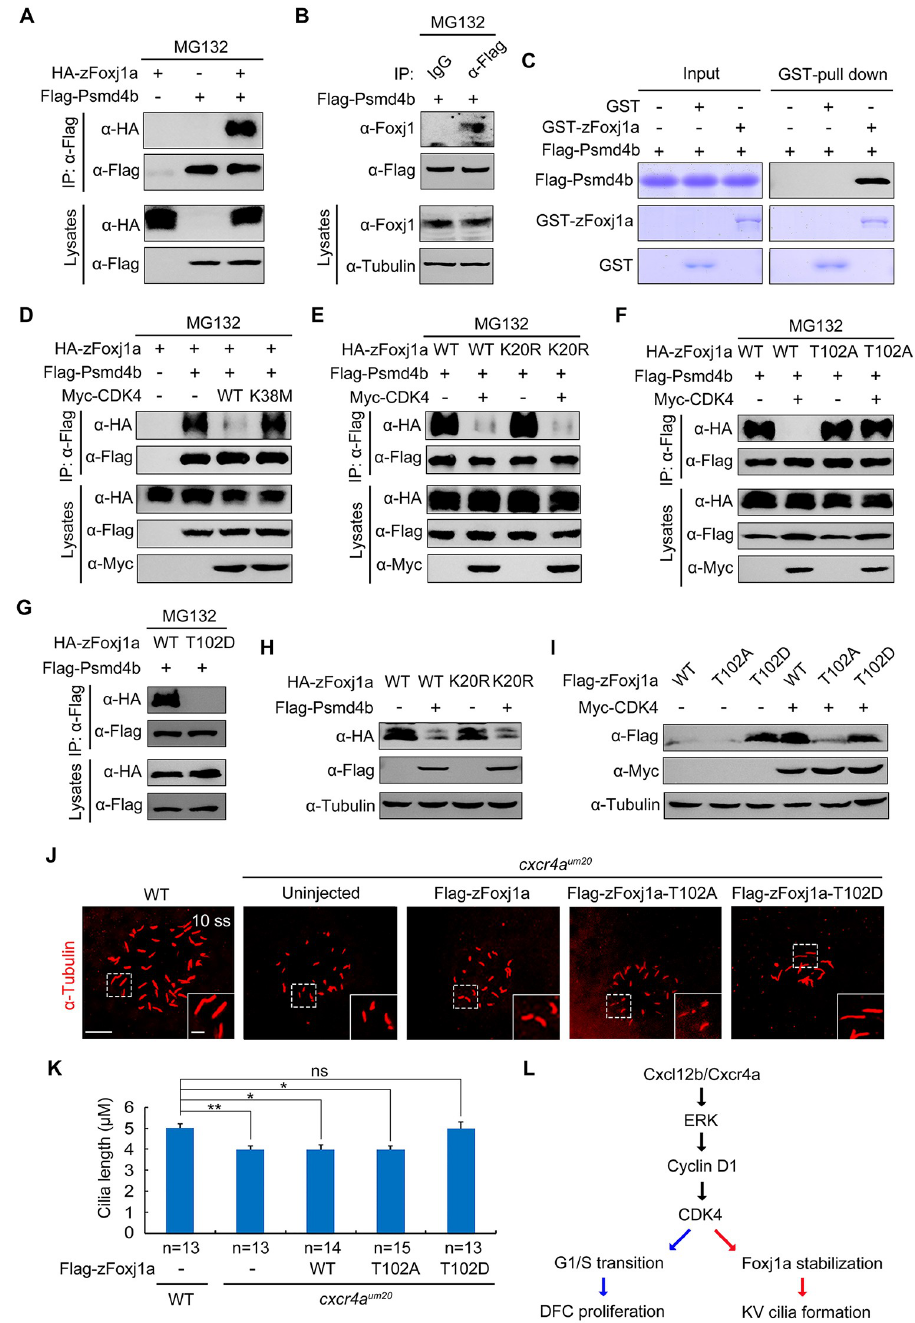
Fig 7. zFoxj1a undergoes Ub-independent proteasomal degradation via a direct interaction with Psmd4b. (A–B) Flag-Psmd4b interacts with overexpressed or endogenous zFoxj1a. HEK293T cells transfected with the indicated constructs (A) and bud-stage WT embryos with DFC-specific expression of Flag-Psmd4b (B) were subjected to immunoprecipitation with the indicated antibodies. (C) In vitro GST pull-down assays reveal a direct interaction between zFoxj1a and Psmd4b. Purified GST or GST-zFoxj1a proteins were incubated with recombinant Flag-Psmd4b. The presence of Flag-Psmd4b in the protein complex that was pulled down by glutathione agarose was assessed by western blot, and input proteins were examined by Coomassie blue staining. (D–E) CDK4 kinase activity is required for its inhibitory effect on the association between Psmd4b and zFoxj1a. HEK293T cells transfected with the indicated plasmids were treated with MG132 for 5 hours prior to harvest for immunoprecipitation. Note that ectopically expressed CDK4 efficiently disrupted the association of Psmd4b with zFoxj1a (D) or its lysine-free mutant